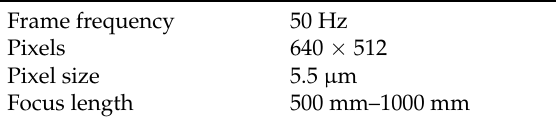
Table 1. CCD Table 1. CCD parameters.